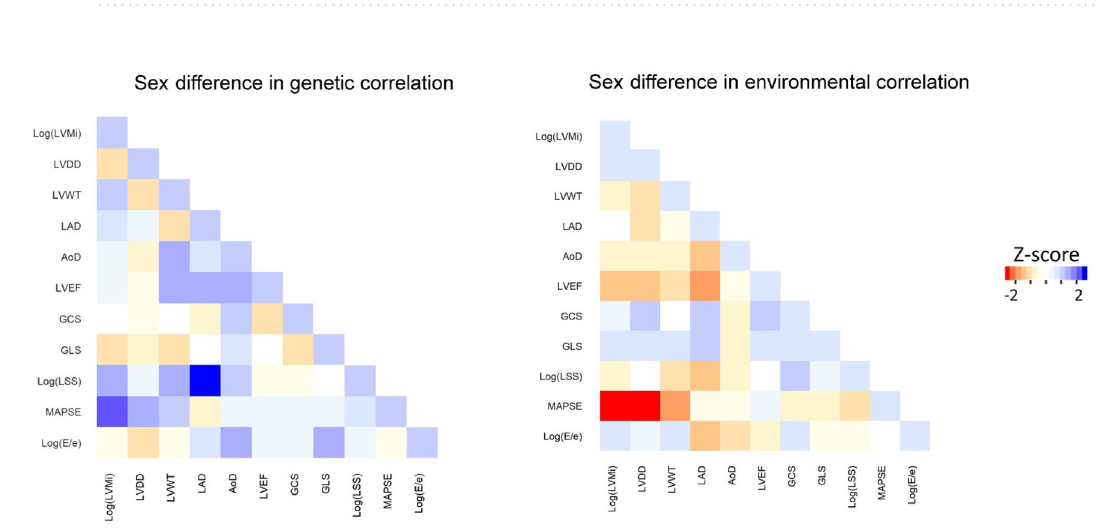
Table 2. Sex-specific genetic/environmental correlations among echocardiographic traits. Upper diagonal values are genetic correlations; lower diagonal values are environmental correlations. *Sex difference with P < 0.05. † Sex difference with P < 0.01.